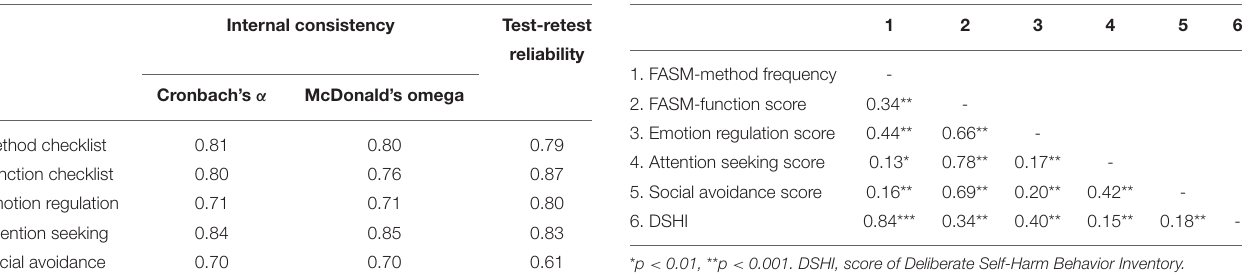
TABLE 5 | Internal consistency and test-retest reliability of the C-FASM. TABLE 6 | Correlations among C-FASM and